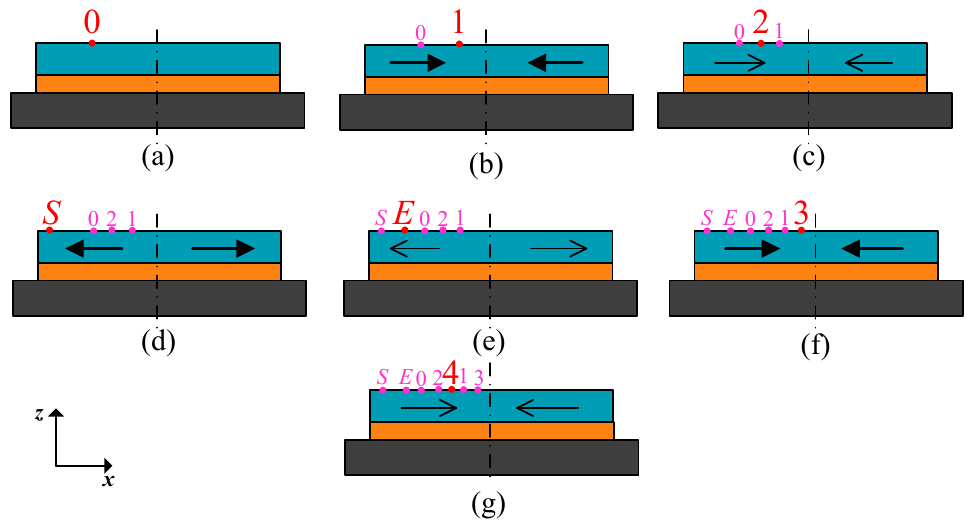
Figure 10. The moving trail of point P 1 at each step in the first thermal cycle at 125 °C. ( a ) Curing process; ( b ) cooling to room temperature; ( c ) room temperature retention; ( d ) starting point of high temperature; ( e ) ending point of high temperature; ( f ) cooling to room temperature again; ( g ) room temperature retention again.